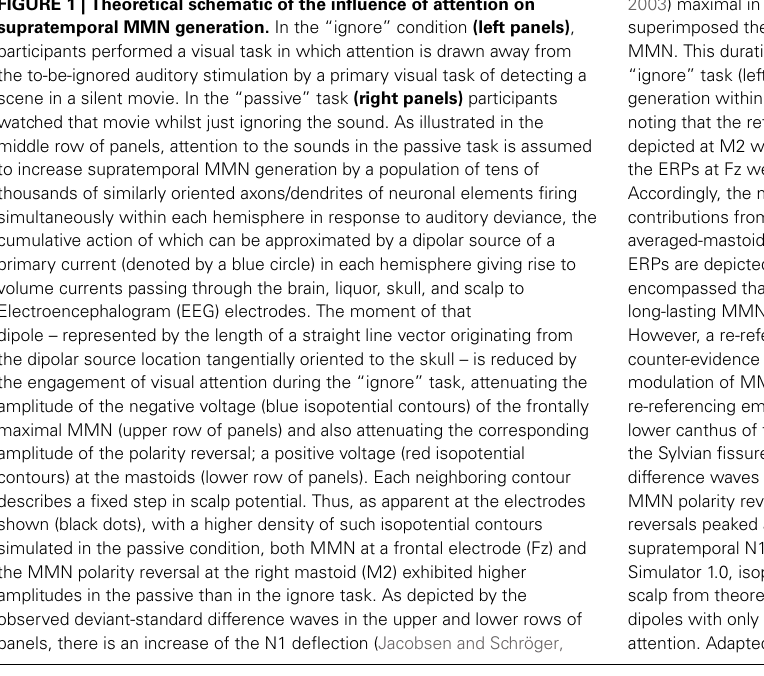
2003) maximal in amplitude 110–170ms post-onset onto which is superimposed the second maximal negativity (right panel), the